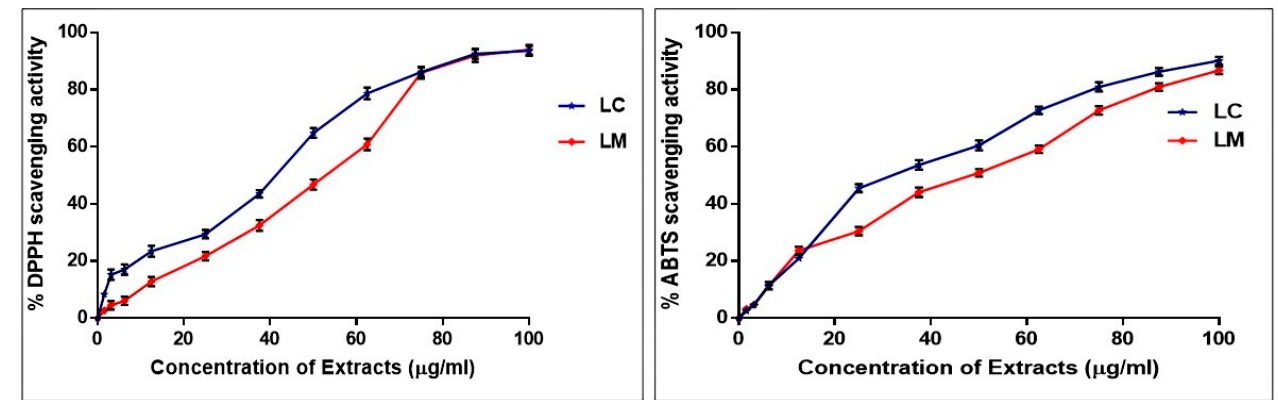
Figure 3. The antioxidant scavenging activity of L. camara and L. montevidensis extracts. Results were expressed as mean ± SE, ( n = 3).